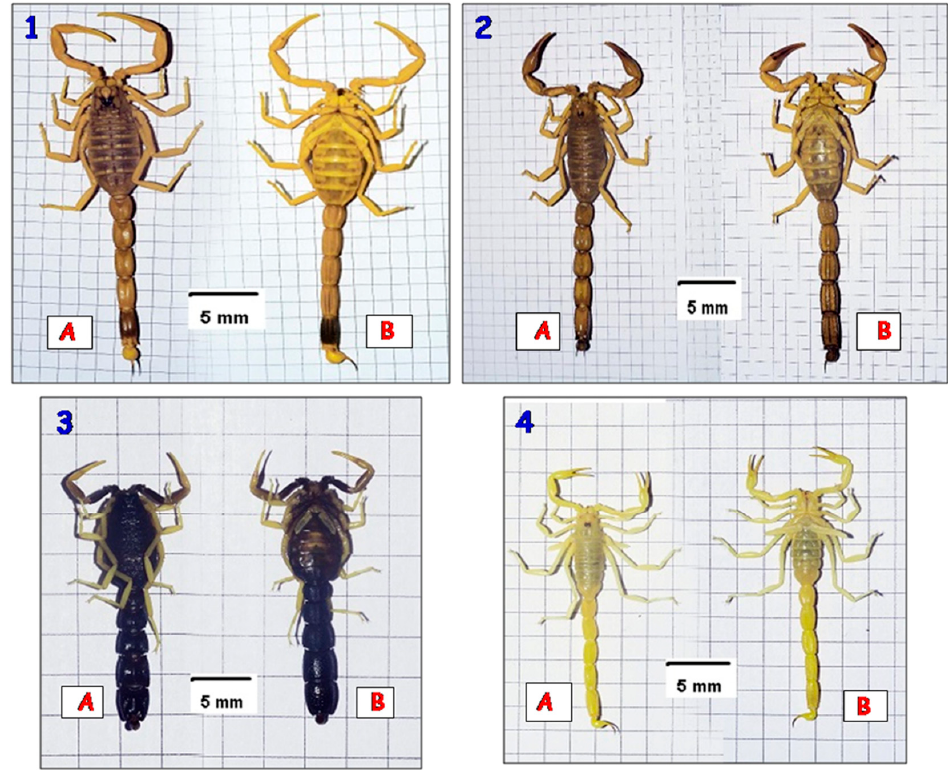
Figure 2. Dorsal ( A ) and ventral ( B ) views for the four scorpion species collected in the current study: Leiurus quinquestri- atus ( 1 ), Androctonus amoreuxi ( 2 ), Orthochirus Innesi ( 3 ), Buthacus leptochelys ( 4 ).